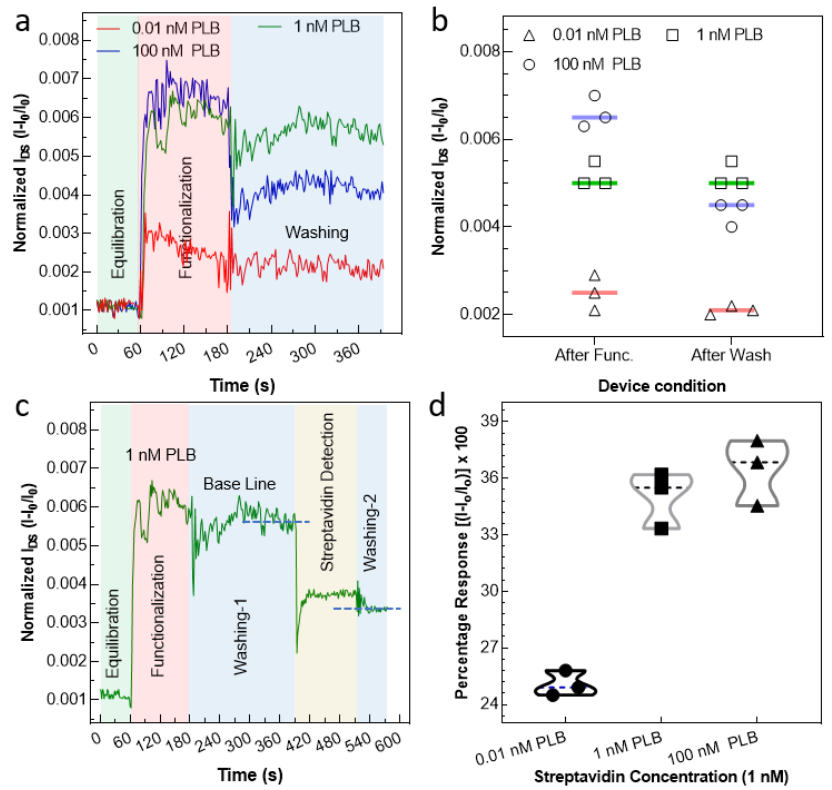
Figure 5. Real-time electrical measurement of the G-FET device. ( a ) The current profile of the device after applying PLB at various concentrations ranging from 0.01 nM to 100 nM. After the current became constant, washing was carried out using the same buffer to get rid of the PLB molecules stacked onto the surface with bonds other than the graphene surface. ( b ) The normalized current for three different devices was measured right after functionalization and after applying the washing step. The experimental investigation revealed that the 1 nM PLB concentration was adequate to functionalize all the graphene channel surfaces, avoiding any surface screening and loss of material due to stacking. ( c ) Finally, the same device was used to detect the streptavidin, since the PLB construct was biotinylated. ( d ) The graph was plotted to observe the percentage response of devices functionalized using various concentrations of PLB. For all the measurements, the concentration of streptavidin was kept constant. The optimum response, i.e., obtaining a max response without wasting material (PLB), was obtained at 1 nM PLB.